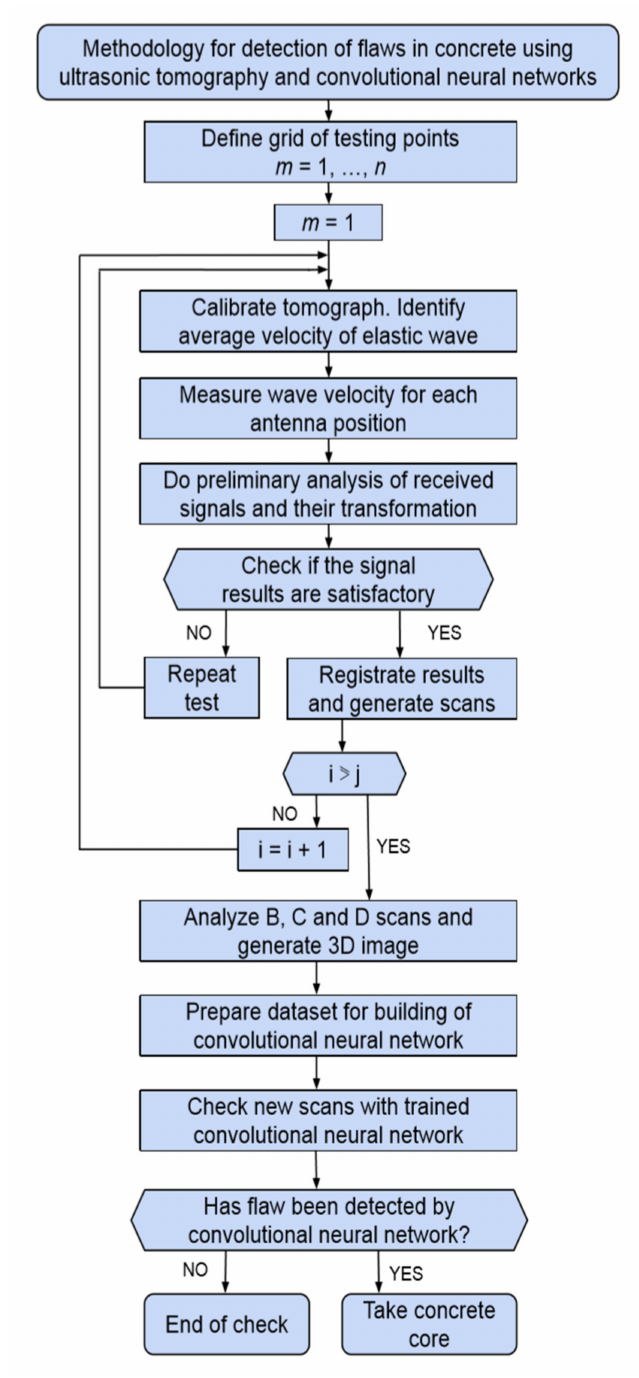
Figure 4. Flowchart presenting methodology for detecting flaws in concrete elements using ultrasonic tomography and convolutional neural